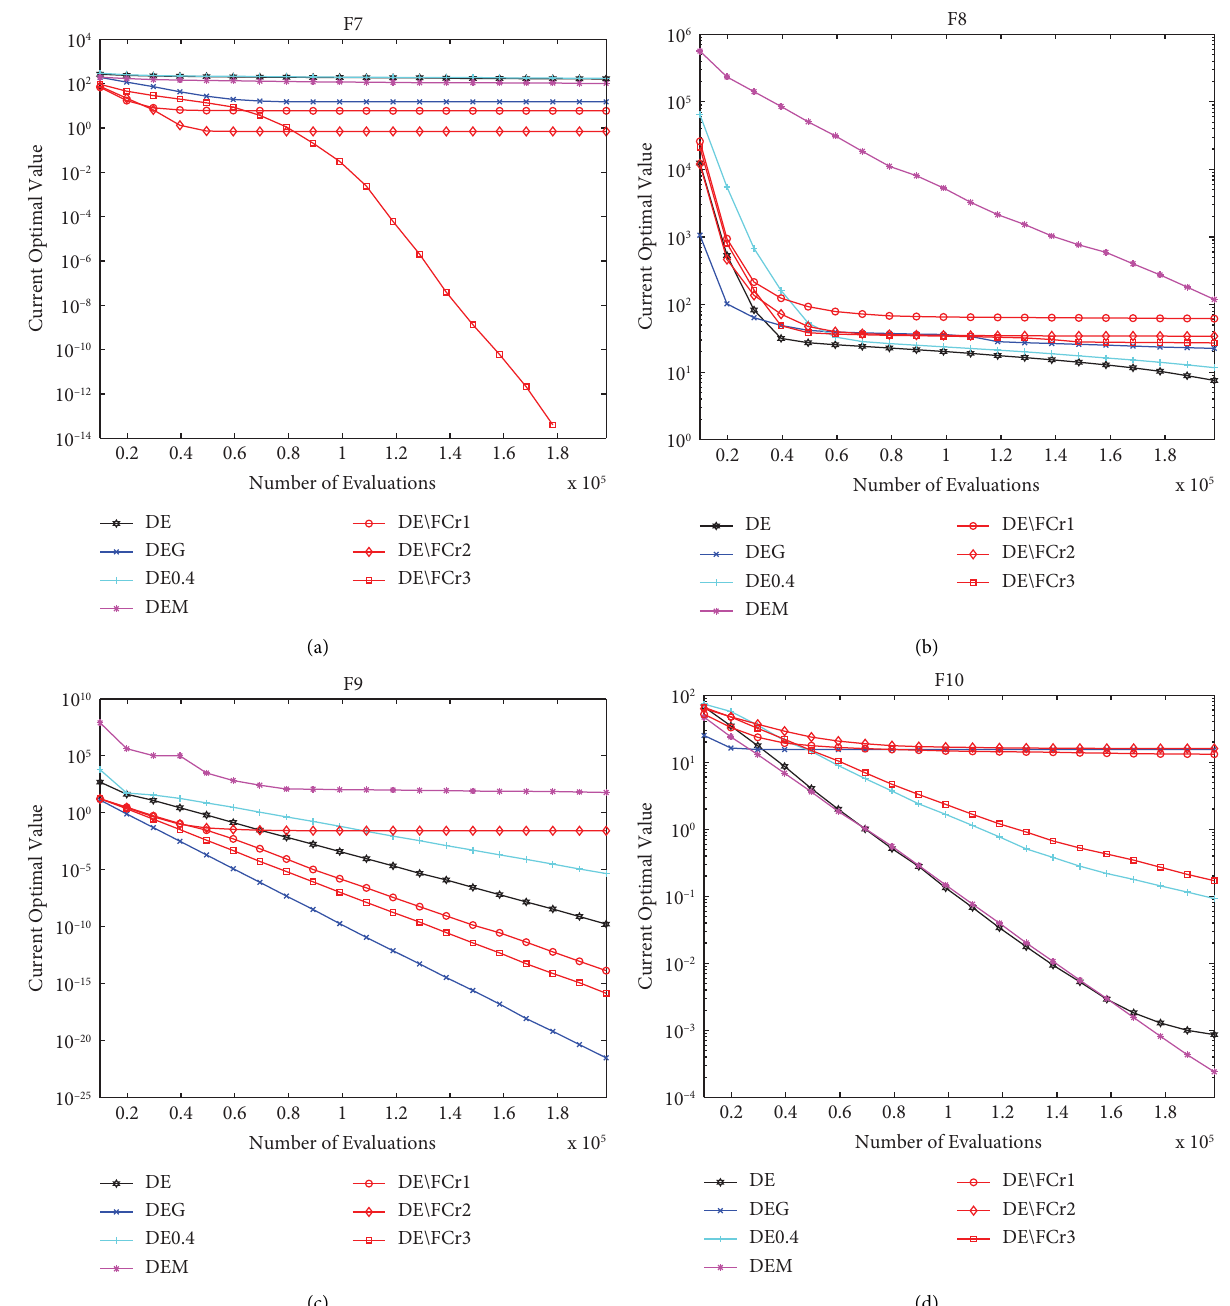
Figure 6: Te mean of the current optimal values obtained by 7 algorithms with the number of function evaluations for F 7– F 10. (a) F 7. (b) F 8. (c) F 9. (d) F